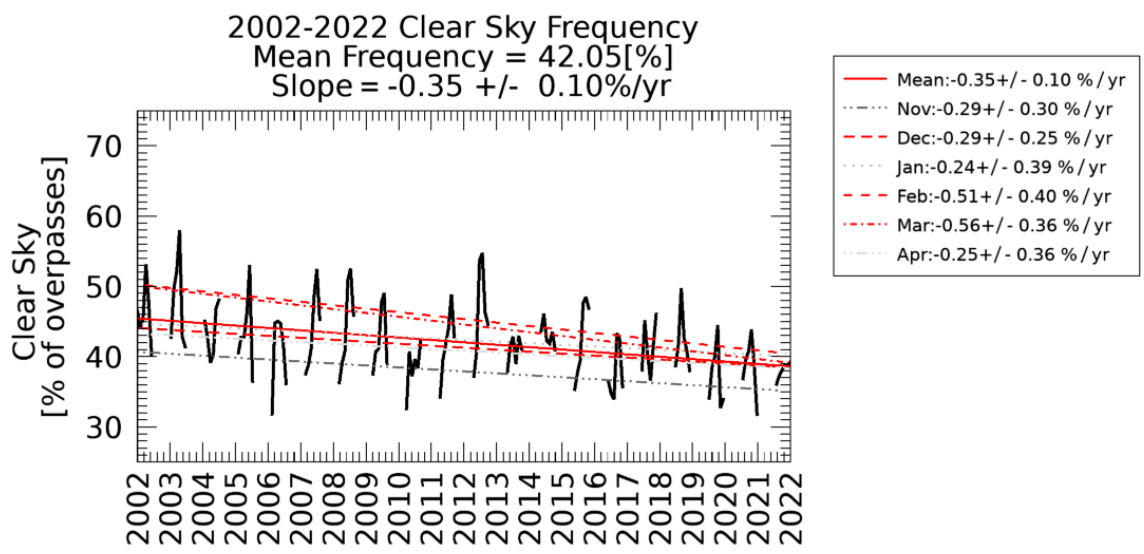
Figure 5. Monthly clear sky frequency for winter months November 2002 through April 2022 as measured by the number of clear sky overpasses in the MODIS cloud mask [32,33] divided by total overpasses. Statistically significant decreases are in red, and shades of gray are used for months with no statistically significant trend.